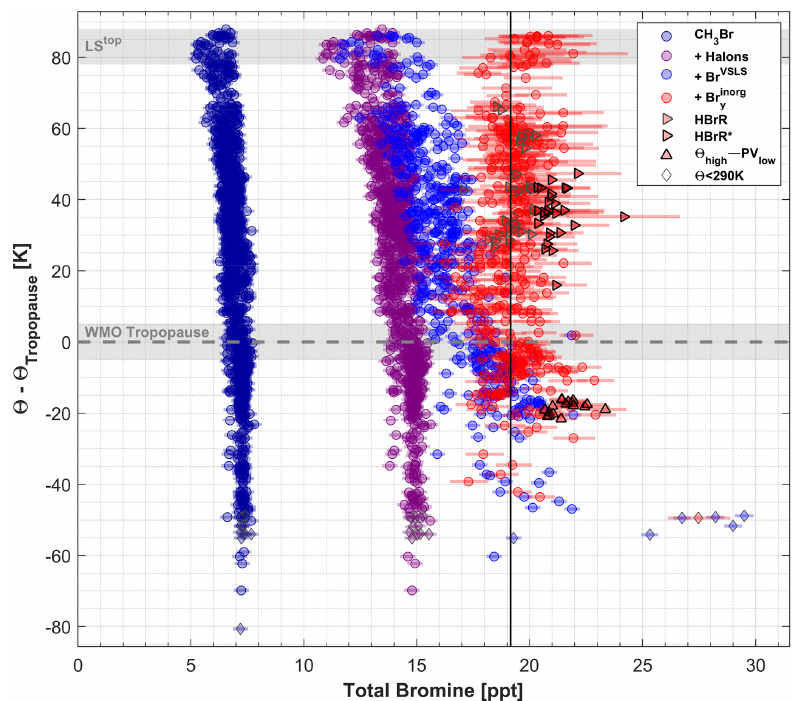
Figure 4. Inferred total bromine, Br tot , as a function of potential temperature distance from the WMO TP (cid:49)(cid:50) = (cid:50) − (cid:50) Tropopause [K] during the WISE campaign in fall 2017. The Br org species are summed up according to their Br atomicity: CH 3 Br (dark blue), four halons (purple), and brominated VSLS (light blue). The inferred Br inorg y is subsequently added (red), resulting in the UTLS Br tot . The solid black line represents the LS weighted mean of [Br tot ] = 19 . 2 ± 1 . 2ppt (1 σ variability). The Br tot measurements from the high bromine region (HBrR) are indicated by right-pointing (gray- and black-edged) triangles (weighted mean [Br tot ] = 19 . 9 ± 1 . 2ppt). The measurements within the HBrR that are larger than the LS mean by at least 1 σ labeled HBrR ∗ are indicated by the black-edged right-pointing triangles alone (mean [Br tot ] = 20 . 9 ± 0 . 8ppt). Measurements in tropical (cid:50) high –PV low air are depicted by the upward-pointing black-edged triangles (mean [Br tot ] = 21 . 6 ± 0 . 7ppt). Measurements from near the surface during takeoff or landing, i.e., (cid:50) < 290K, are depicted by the gray-edged diamond symbols, which include the VSLS mixing ratios > 25ppt in the lower right corner. The bottom and top gray shaded layers indicate the TP region ( (cid:49)(cid:50) = ± 5K) and the LS top region (upper LS measurements: (cid:49)(cid:50) = 78–88K),